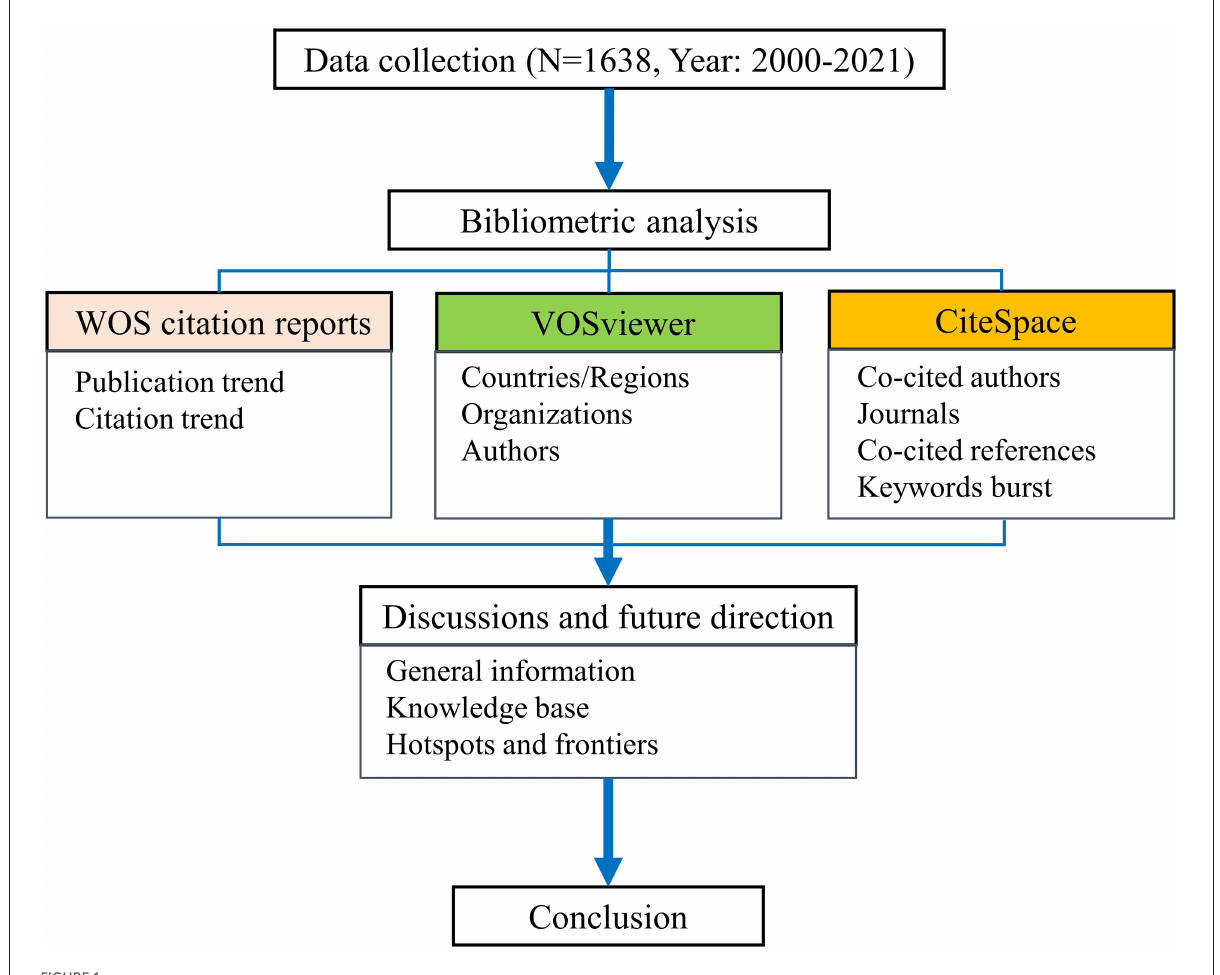
FIGURE1 The diagram of article